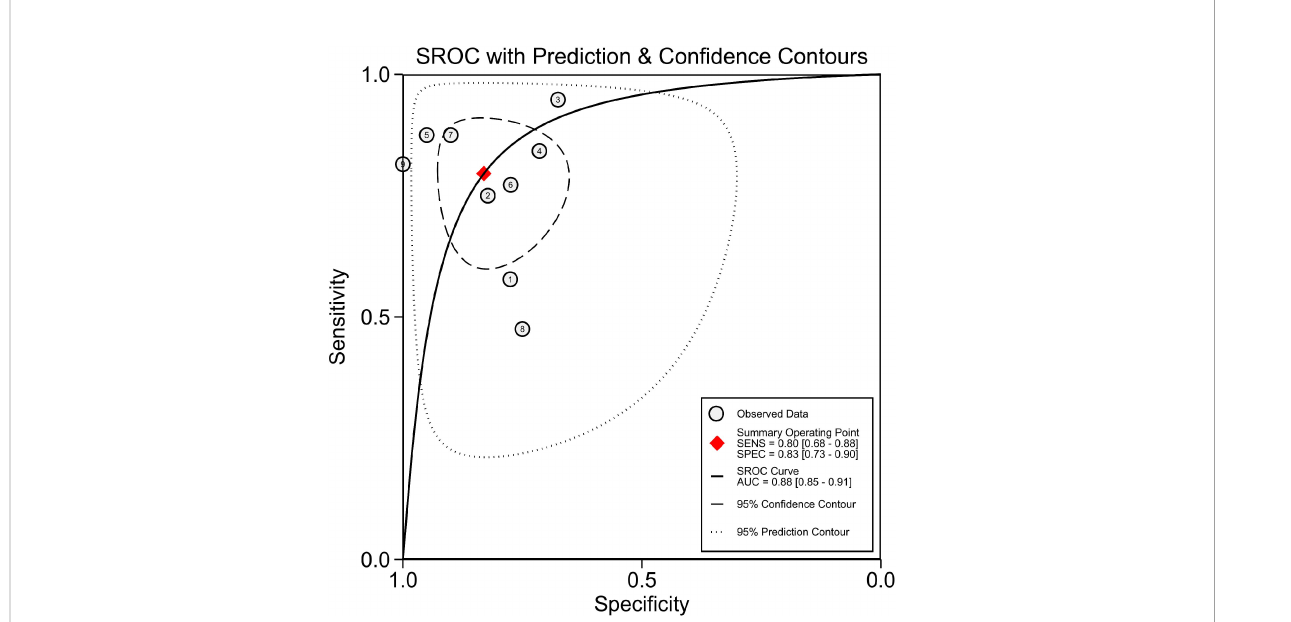
FIGURE 3 Summary receiver operating characteristic (SROC). AUC, area under the curve.